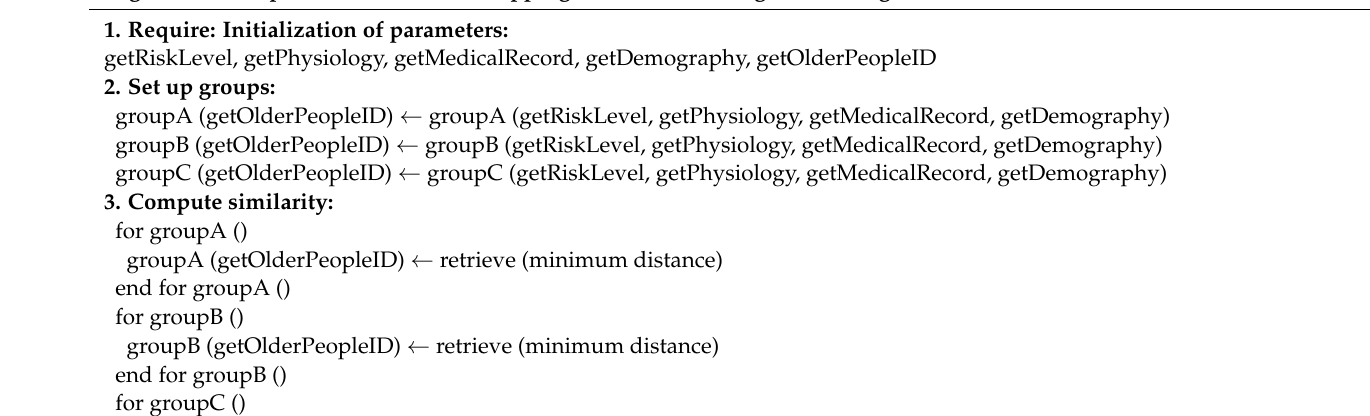
Algorithm 1. Implementation of the Mapping Mutual Clustering (MMC)